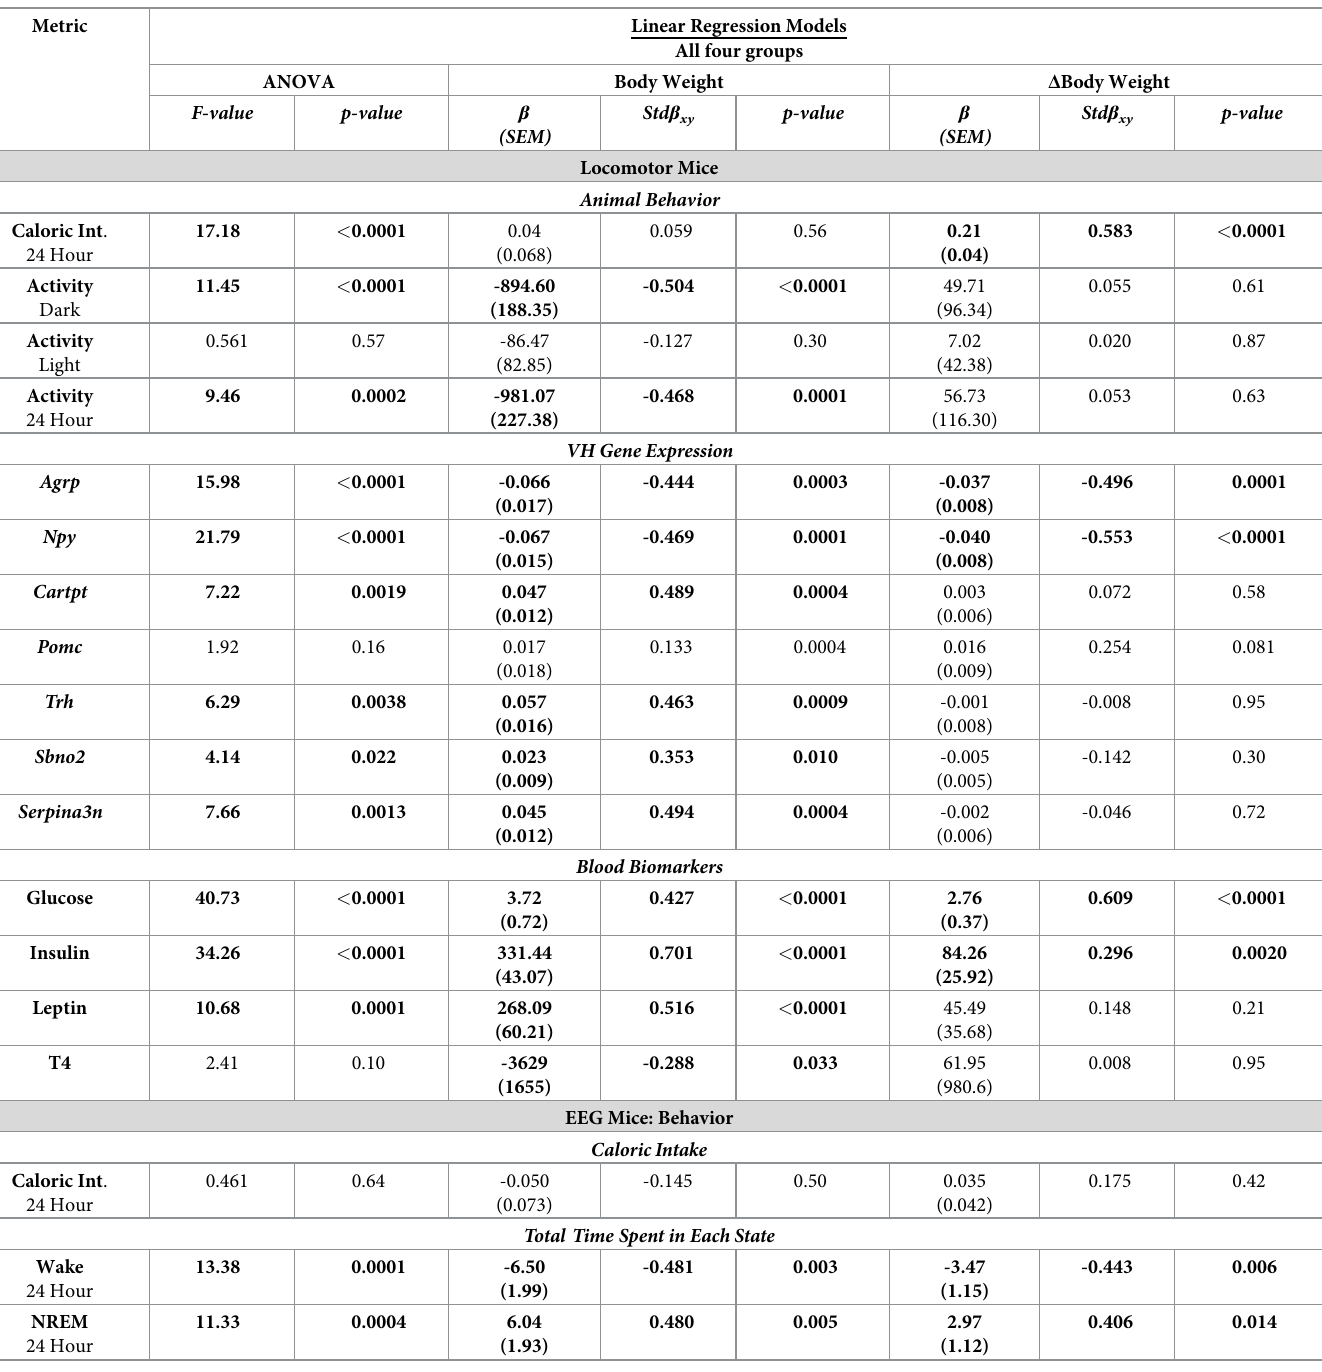
Table 3. Linear modeling results using body weight and Δ body weight as predictors from all